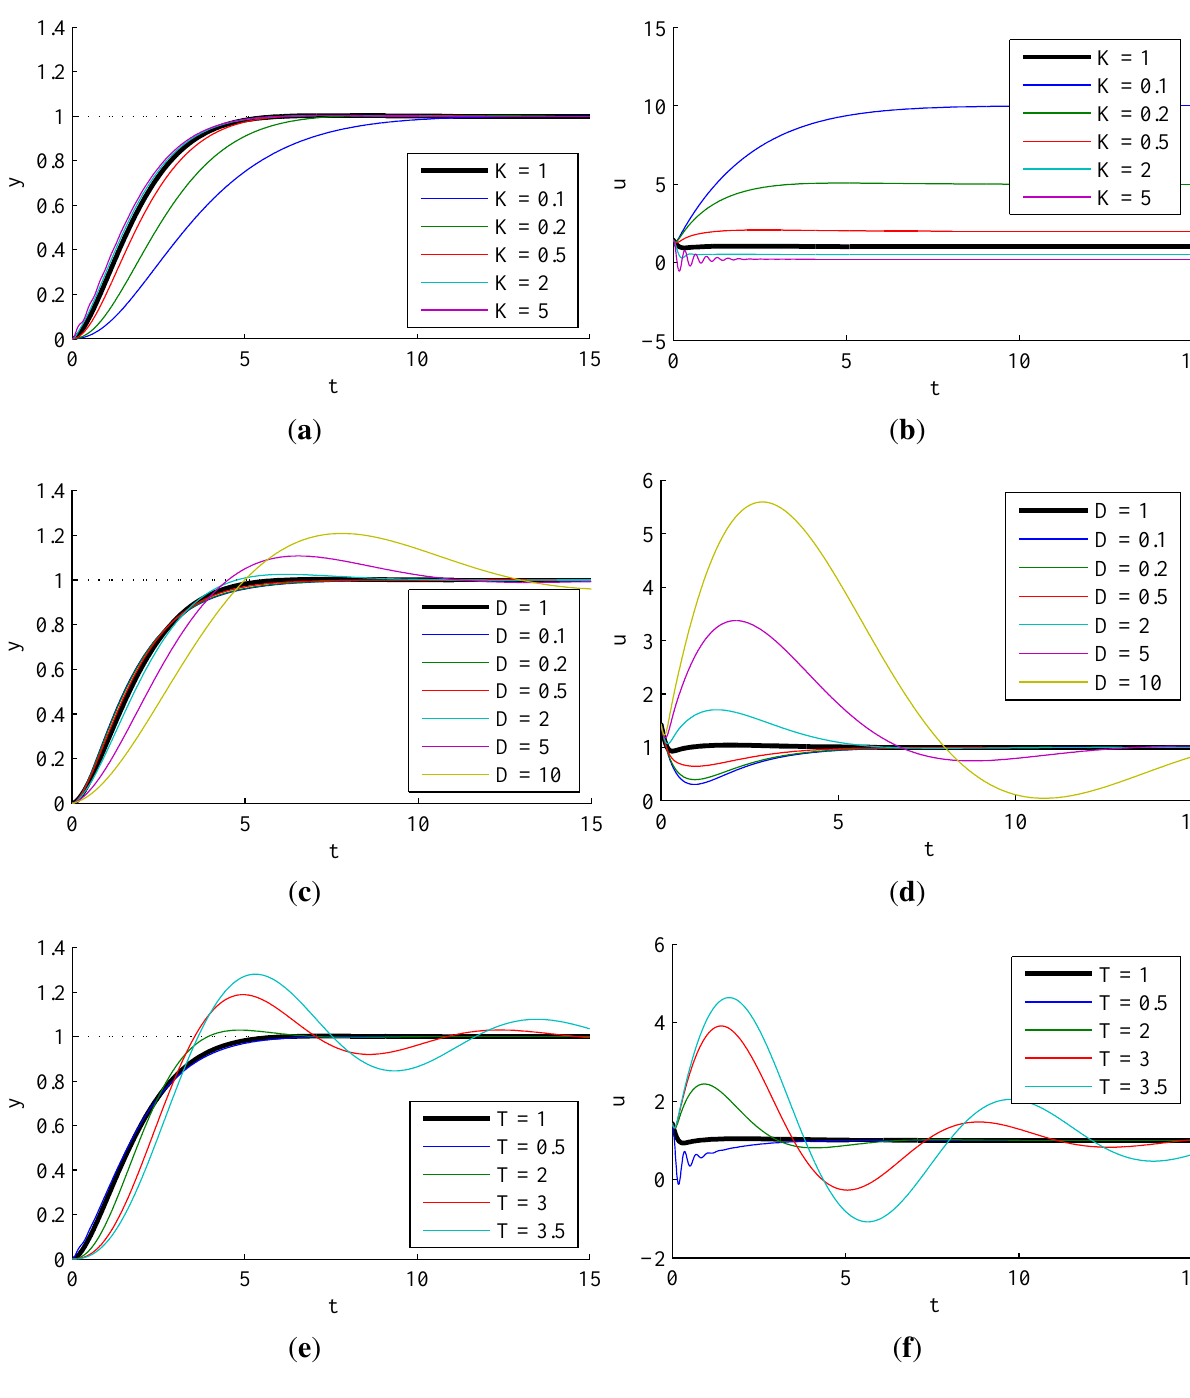
Figure 11. Experiment 3.2.1: a fixed second-order ADRC controlling second-order process with varying parameters. Nominal process parameters: K = 1, D = 1, T = 1. ADRC = K = 1, T = 5, s ESO = 10 s CL . ( a ) Variation of K , closed loop step parameters: b 0 settle T 2 · response; ( b ) Controller output u for ( a ); ( c ) Variation of D , closed loop step response; ( d ) Controller output u for ( c ); ( e ) Variation of T , closed loop step response; ( f ) Controller output u for ( e